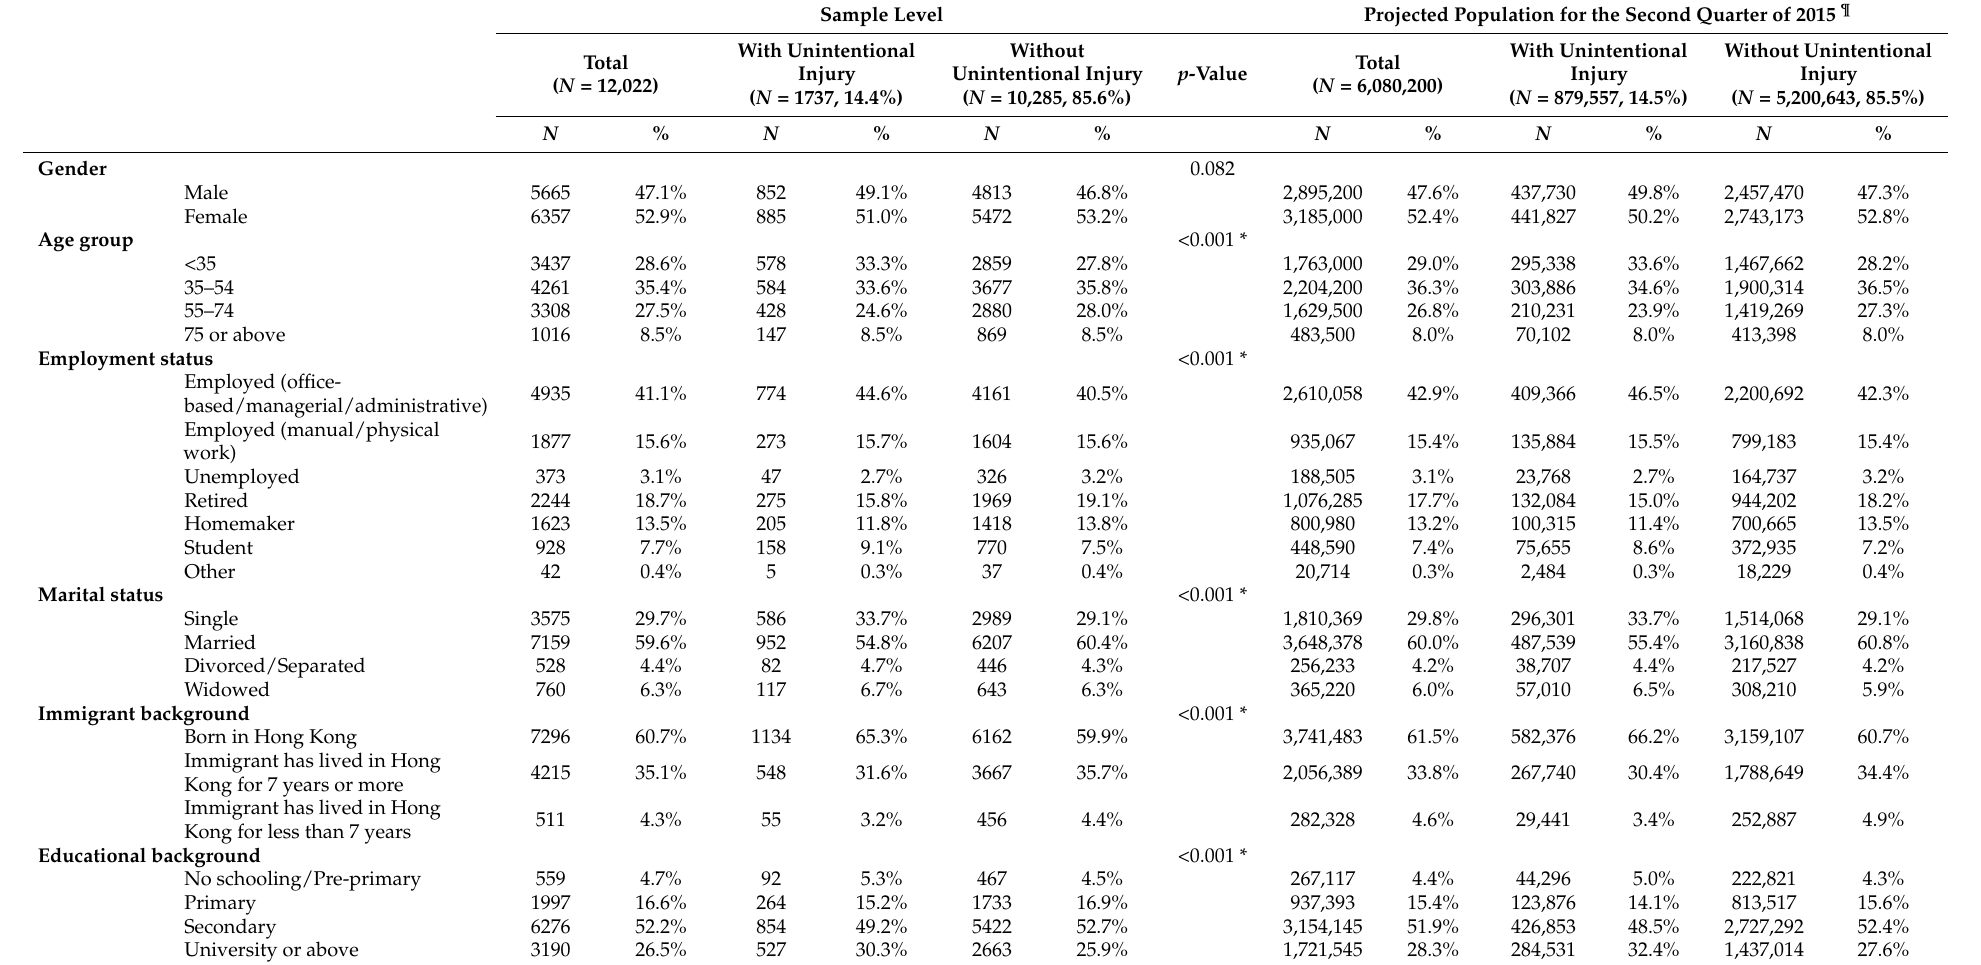
Table 1. Characteristics of study participants by whether or not they experienced an unintentional injury in the previous 12